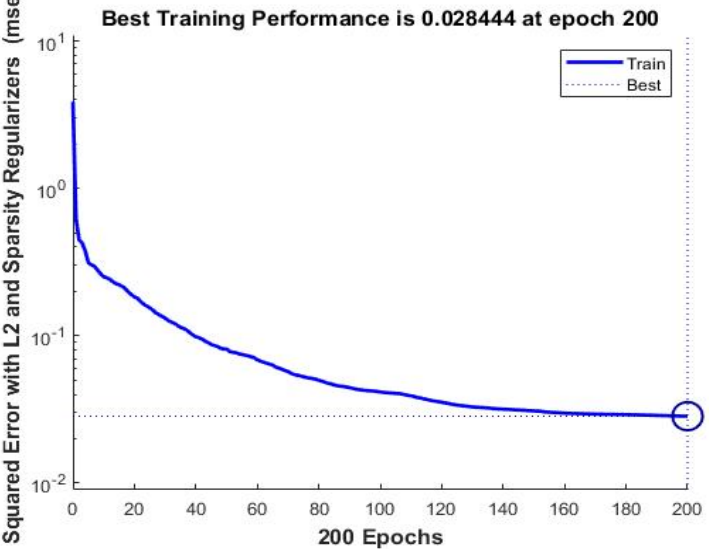
Figure 11. The learning curve for the proposed SSAE deep neural network for the OLR database.